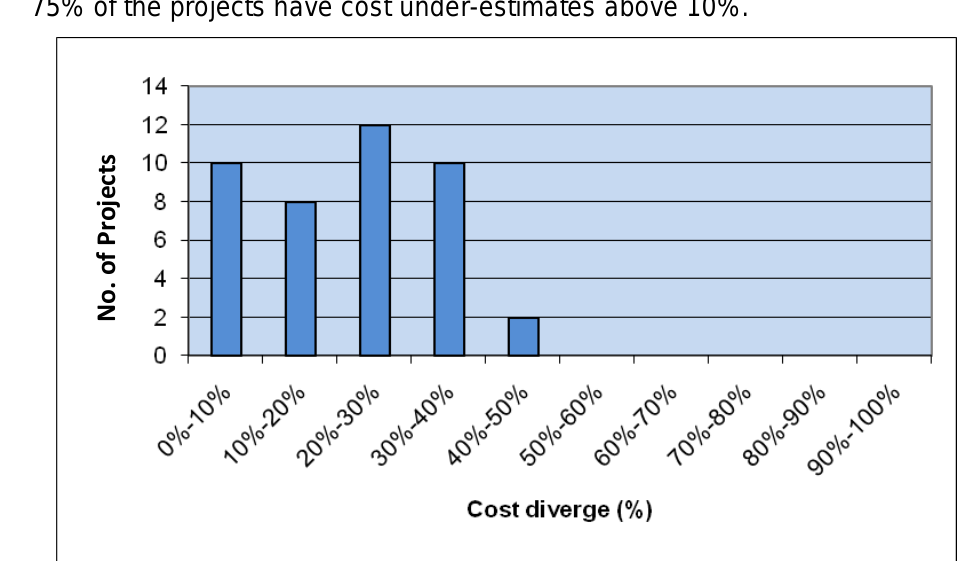
Figure 7 Cost under-estimates vs. no of projects in medium sized road construction projects